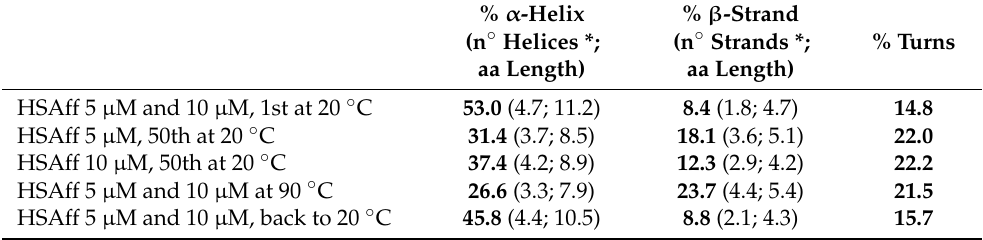
Figure 5. CD spectra in Δε unit of 5 µM identical to those of 10 µM of HSAff at 20 °C (solid blue), 90 °C (dashed blue), and back at 20 °C (dashed-dotted blue). First (solid) and 50th (dashed) SRCD spectra of HSAff 5 µM (pink) and 10 µM (green). The SRCD spectra measured after 24 h were identical to the 50th consecutive repeated scans of both 5 µM and 10 µM HSAff (spectra not shown). Table 1. Secondary Structure Estimation (SSE) from spectra of Figure 4, SRCD data of 5 µM and 10 µM HSAff for UV irradiation (1st and 50th spectra at 20 °C) and from CD data measured at 20 °C, 90 °C and cooled back to 20 °C. SSE was calculated using CONTINLL [17] with SP37 data set of 37 soluble proteins.